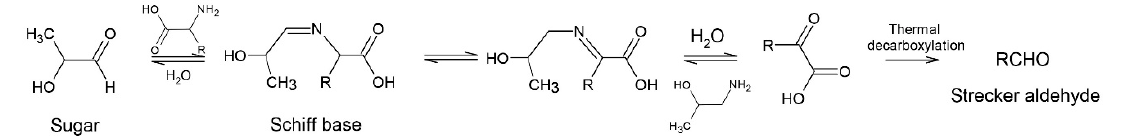
Figure 2. Strecker-type reaction for formation of aldehydes during roasting of cocoa beans.